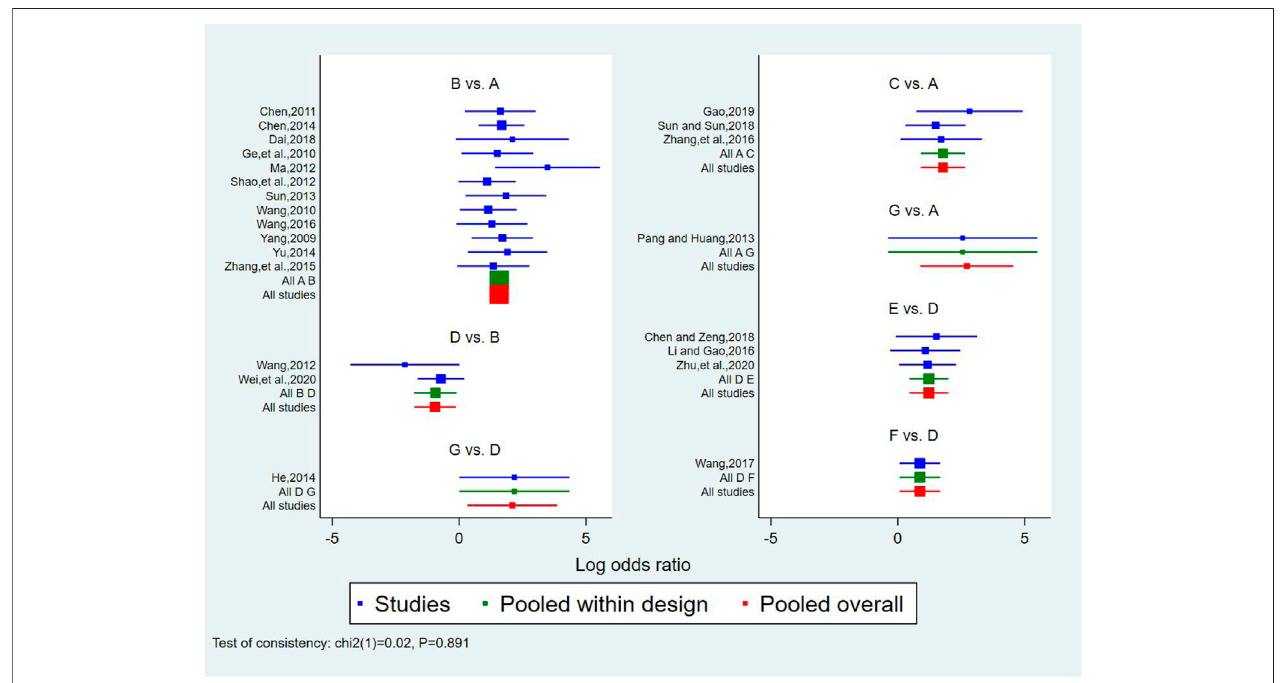
FIGURE 4 | Forest diagram of direct comparison of effectiveness rate. A: conventional treatment; B: conventional treatment + trimetazidine + Astragalus injection; C: conventional treatment + trimetazidine + Shenfu injection; D: conventional treatment + trimetazidine; E: conventional treatment + trimetazidine + Salviae miltiorrhizae and ligustrazinehydrochloride injection;F:conventionaltreatment+trimetazidine+ Breviscapine injection;G:conventionaltreatment+trimetazidine+Shenmaiinjection.